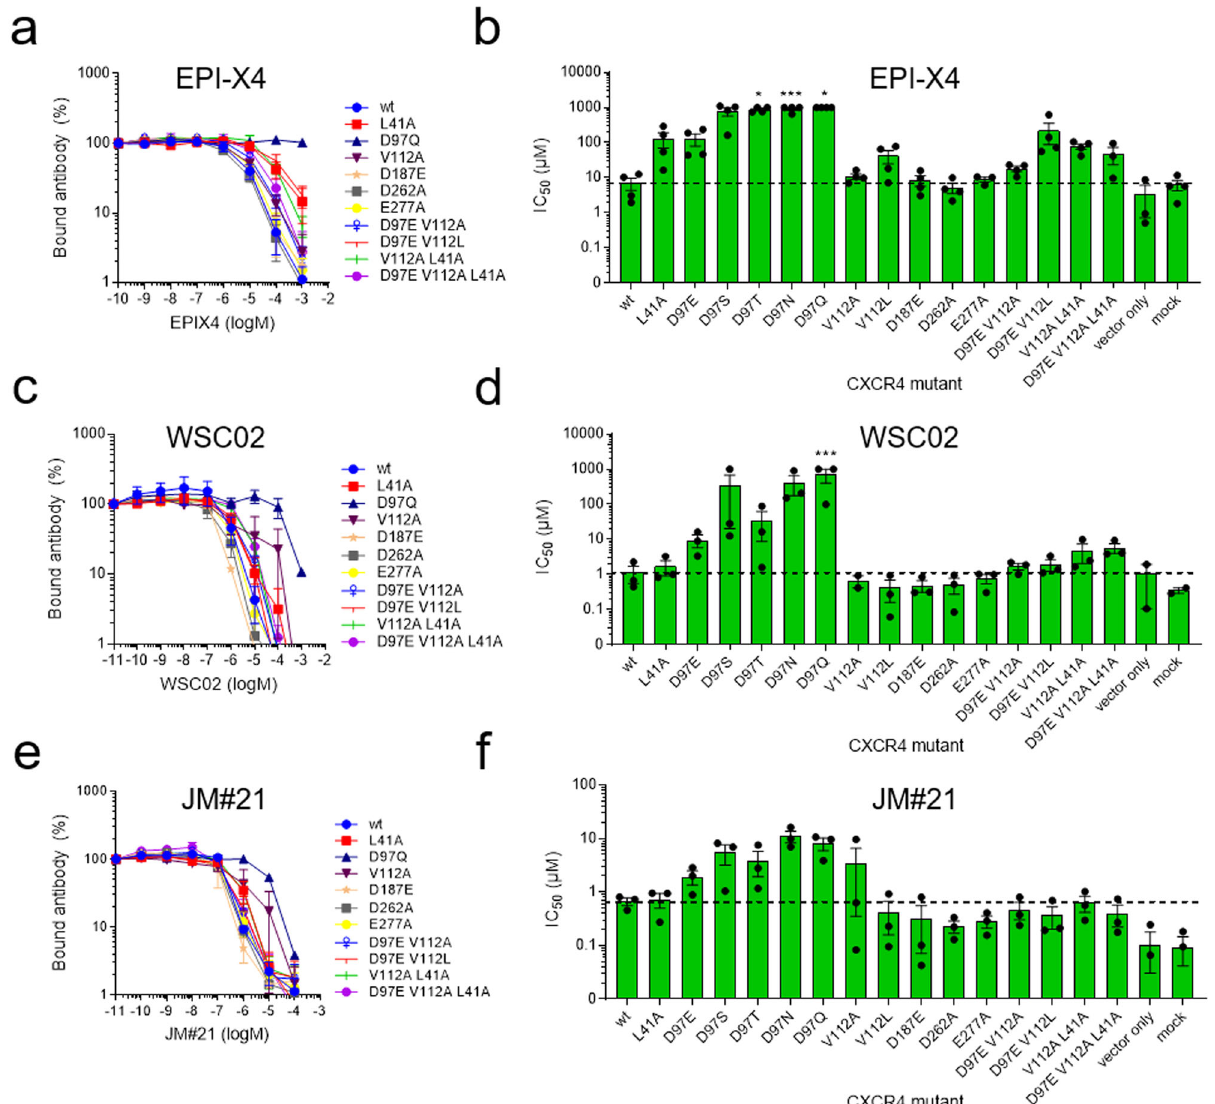
Fig. 4 The interactions of EPI-X4 and the EPI-X4 derivatives WSC02 and JM#21 with point-mutated CXCR4 were assessed by an antibody competition assay. Amino acid substitutions were introduced in the sequence of CXCR4 by site-directed mutagenesis, cloned into an IRES-eGFP expression vector, and transfected into 293 T cells. Afterward, cells were incubated with serially diluted EPI-X4 ( a , b ), WSC02 ( c , d ), or JM#21 ( e , f ) in presence of a constant concentration of CXCR4 speci fi c antibody (clone 12G5). After 2 h, bound antibody was analyzed by fl ow cytometry. a , c , e ) Representative dose-dependent replacement of 12G5 antibody by peptides. b , d , f ) IC 50 values were calculated by nonlinear regression. Shown are data derived from at least three individual experiments ± SEM. IC 50 values were set to 1000 µ M (EPI-X4 and WSC02) or 100 µ M (JM#21) if the value exceeds the maximally used concentration. * p ≤ 0.05, *** p ≤ 0.001 (one-way ANOVA for comparison with wt). For IC 50 values see Table 1. For all binding curves see also Fig.